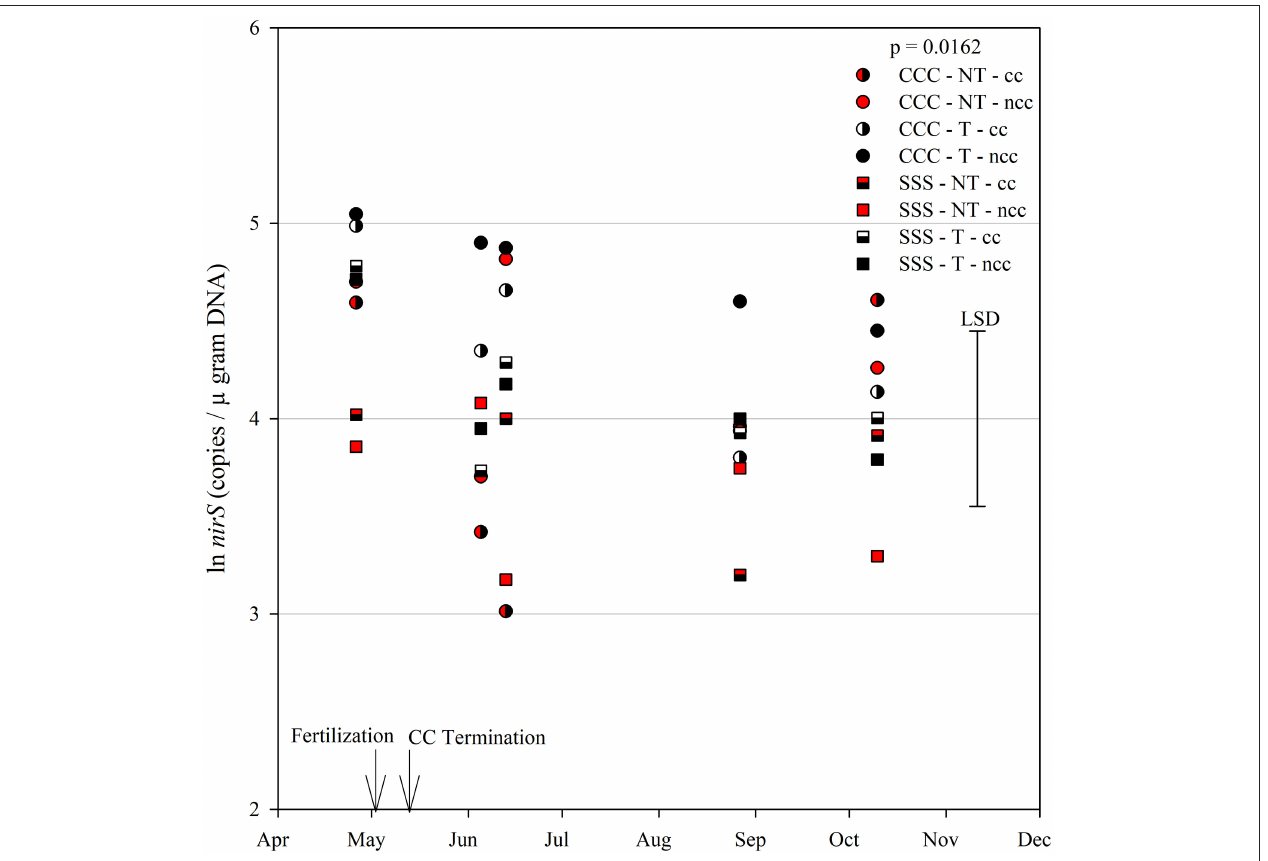
FIGURE 8 | Mean lognormal transformed soil nirS (copies µ gram DNA − 1 ) throughout the 2019 growing season separated by crop rotation [CCC, continuous corn (circles); SSS, continuous soybean (squares)], tillage [NT, no-till (red); T, chisel tillage (black)], and cover crop [CC, cover crop (partial fill); NCC, no cover crop (solid fill)]. Significant differences in treatment means can be interpreted by the Least Square Differences (LSD) error bar to the right of the figure. Mean values that fall beyond the distance of the LSD are significant at α =